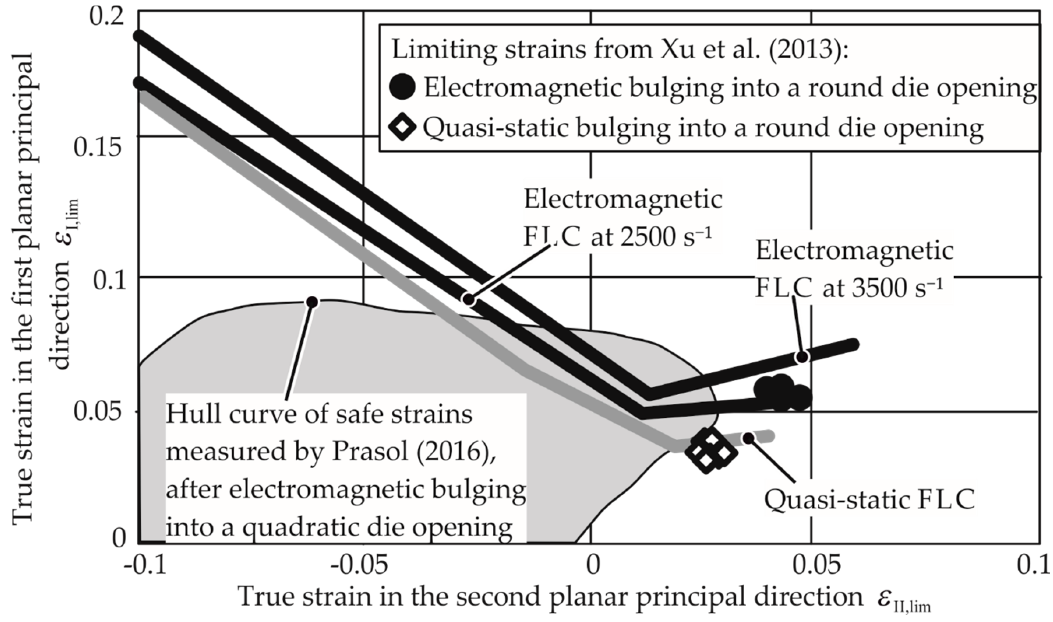
Figure 19. Results of Xu et al. [28] and Prasol [29] are compared with the EM-FLCs determined in this work. Mg AZ31-O, sheet thickness 1 mm. work. Mg AZ31-O, sheet thickness 1